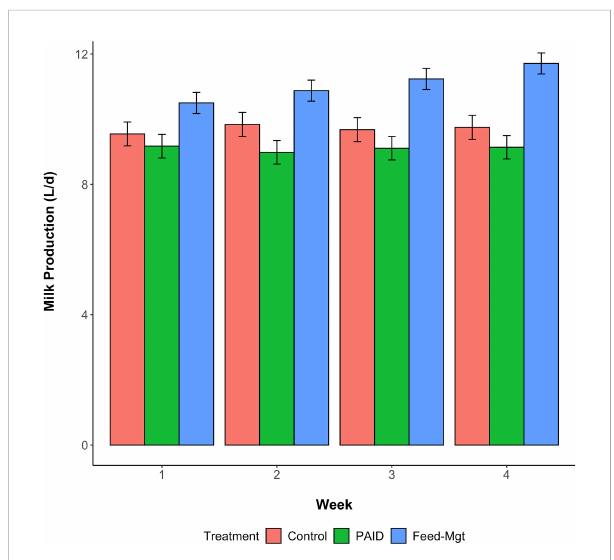
FIGURE 2 Milk production (L/d) per treatment per region weeks after intervention.